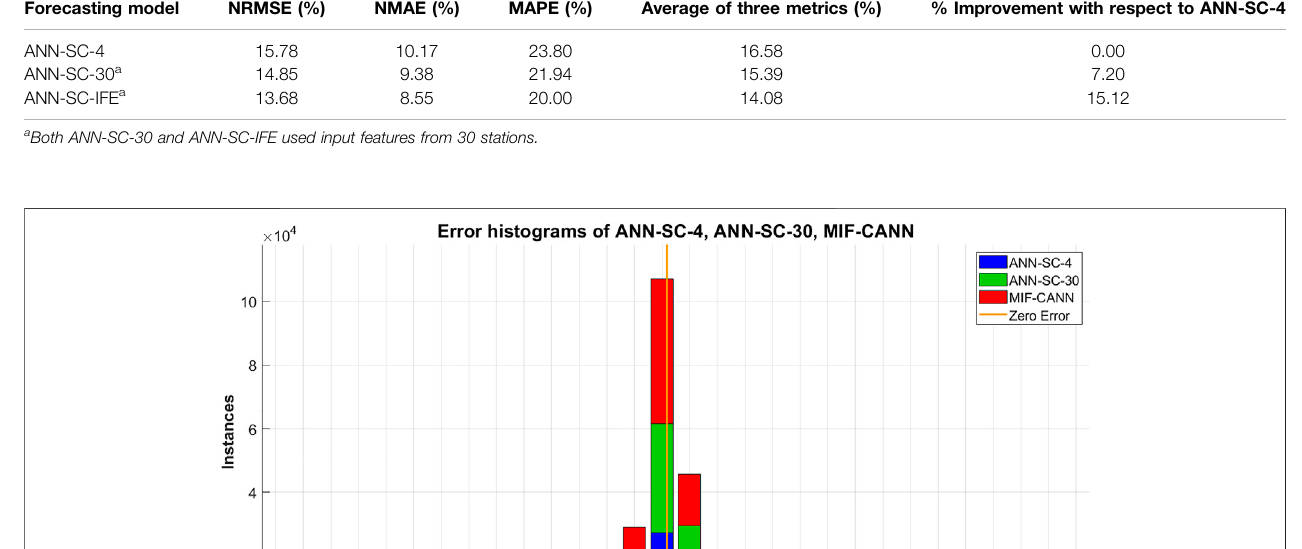
TABLE 8 | Simulation results of 2 h-ahead wind power forecasting of the three forecasting approaches. Forecasting model